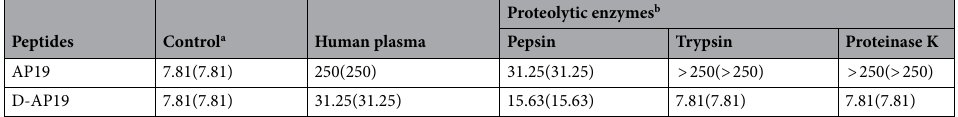
Table 4. The antimicrobial activity (MIC and MBC) (µg/ml) of AP19 and D-AP19 against A. baumannii ATCC 19,606 in the presence of human plasma of A. baumannii and proteolytic enzymes. a Control MIC was evaluated in the absence of human plasma and proteolytic enzymes. c The final concentration of all proteolytic enzymes (pepsin, trypsin and proteinase K) was 1